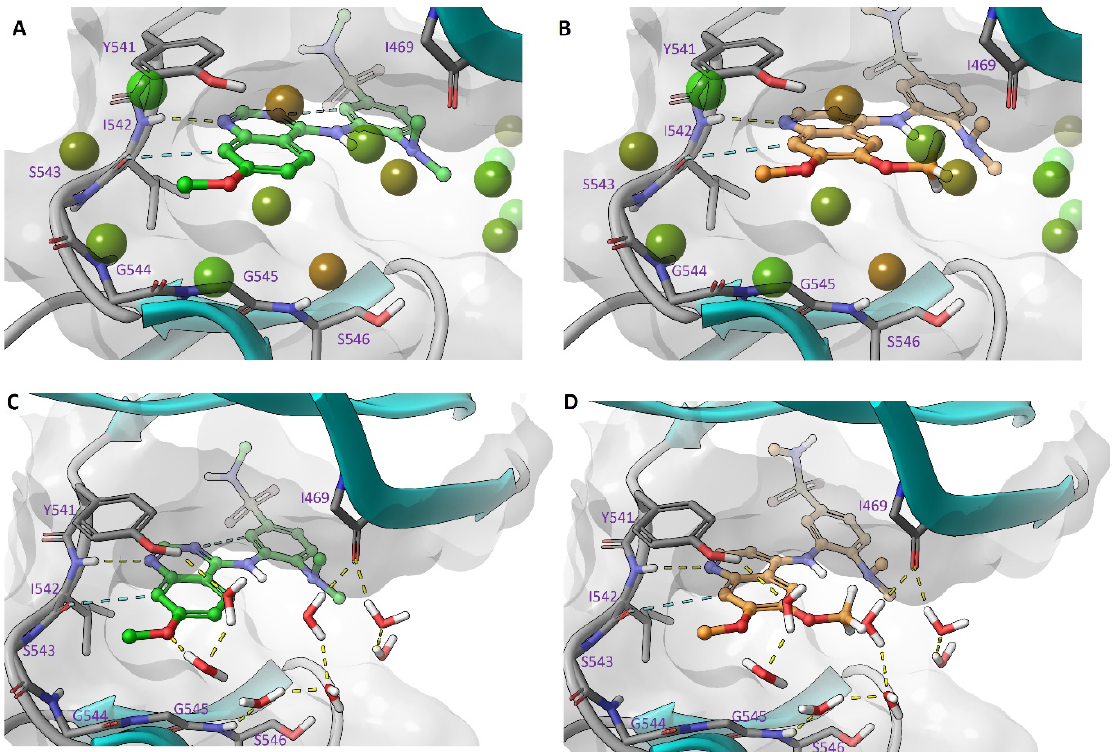
Figure 5. Docked 17 and 7 in the TNNi3K ATP binding site (PDB: 4YFF). WaterMap of 17 ( A ) and 7 ( B ) showing water molecules as spheres and WaterMap of 17 ( C ) and 7 ( D ) showing water molecules with hydrogen bonding networks.